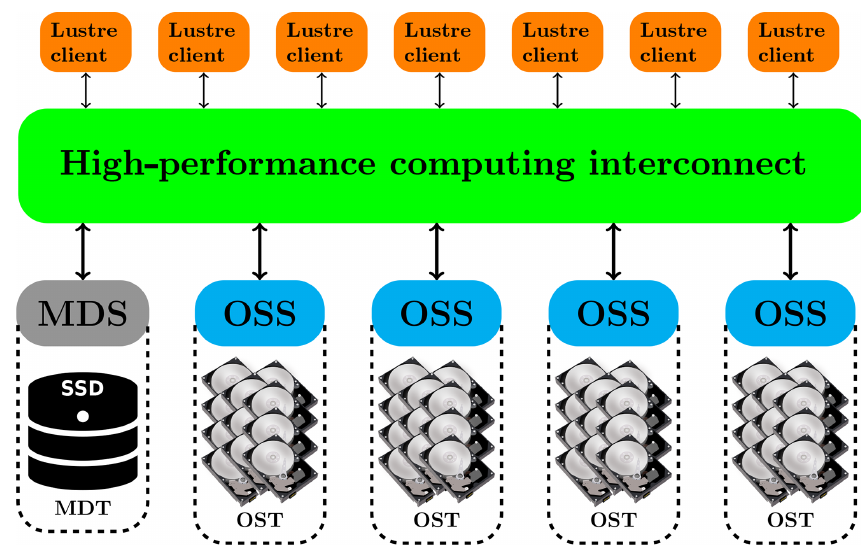
Figure 4. Schematic diagram of a Lustre parallel file system; see Sect. 3.2.1 for the definitions of the abbreviations of MDS, OSS, MDT, OST, and SSD.